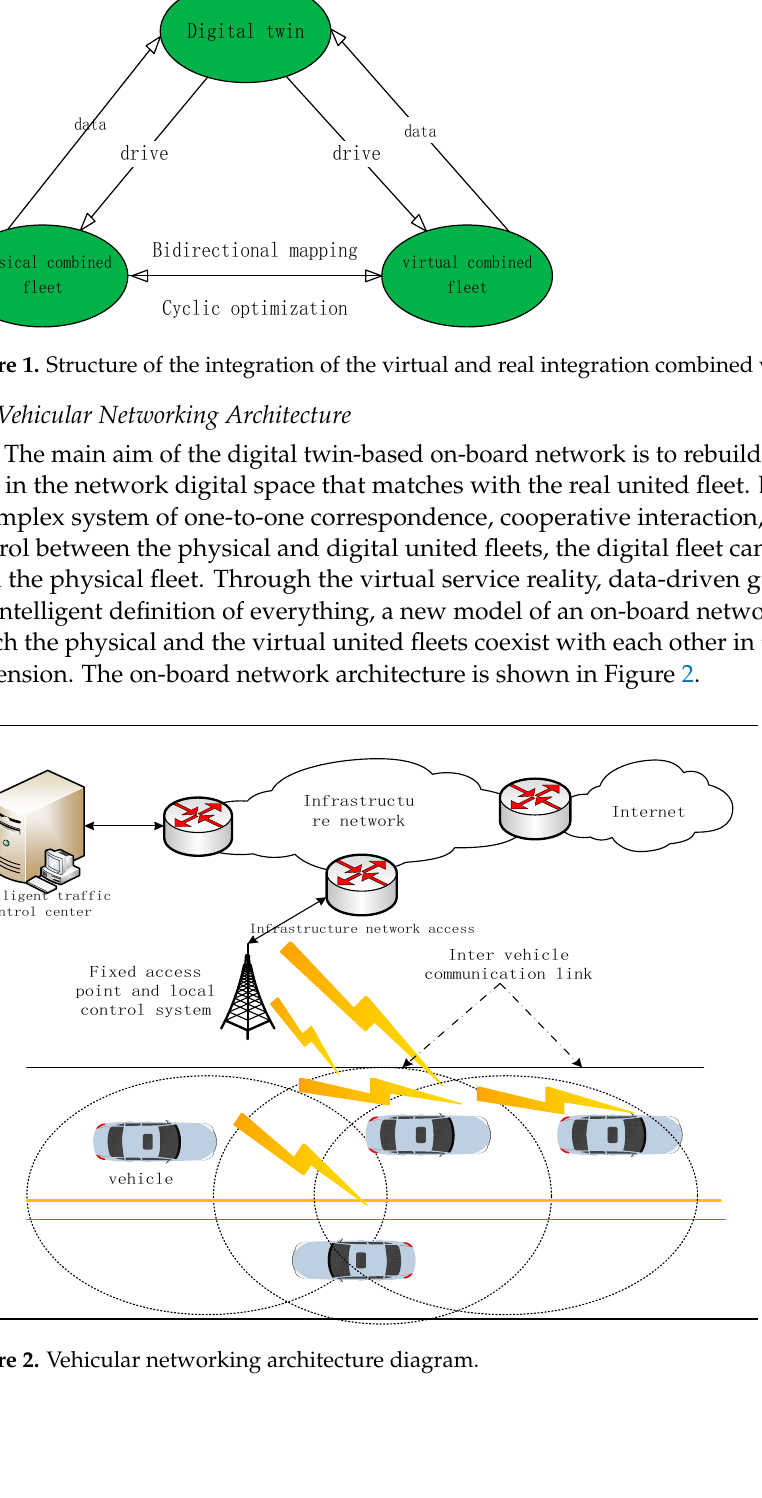
Virtual model Figure 3. Architecture of the vehicular network system based on digital twins.